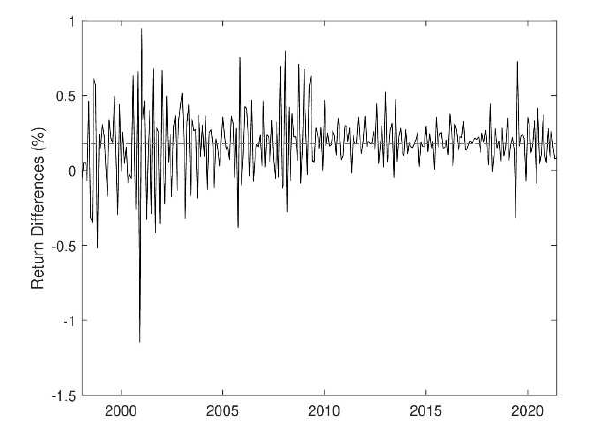
Figure 7. Return differences (TE) of DIA and DJIA